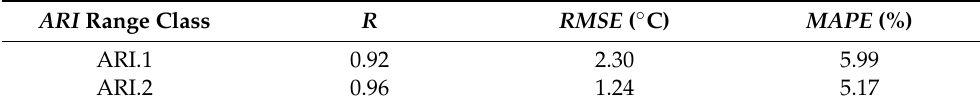
Table 9. Example 3.0.2. Statistical parameters for the courtyard measured temperature in each selected courtyard of each ARI range